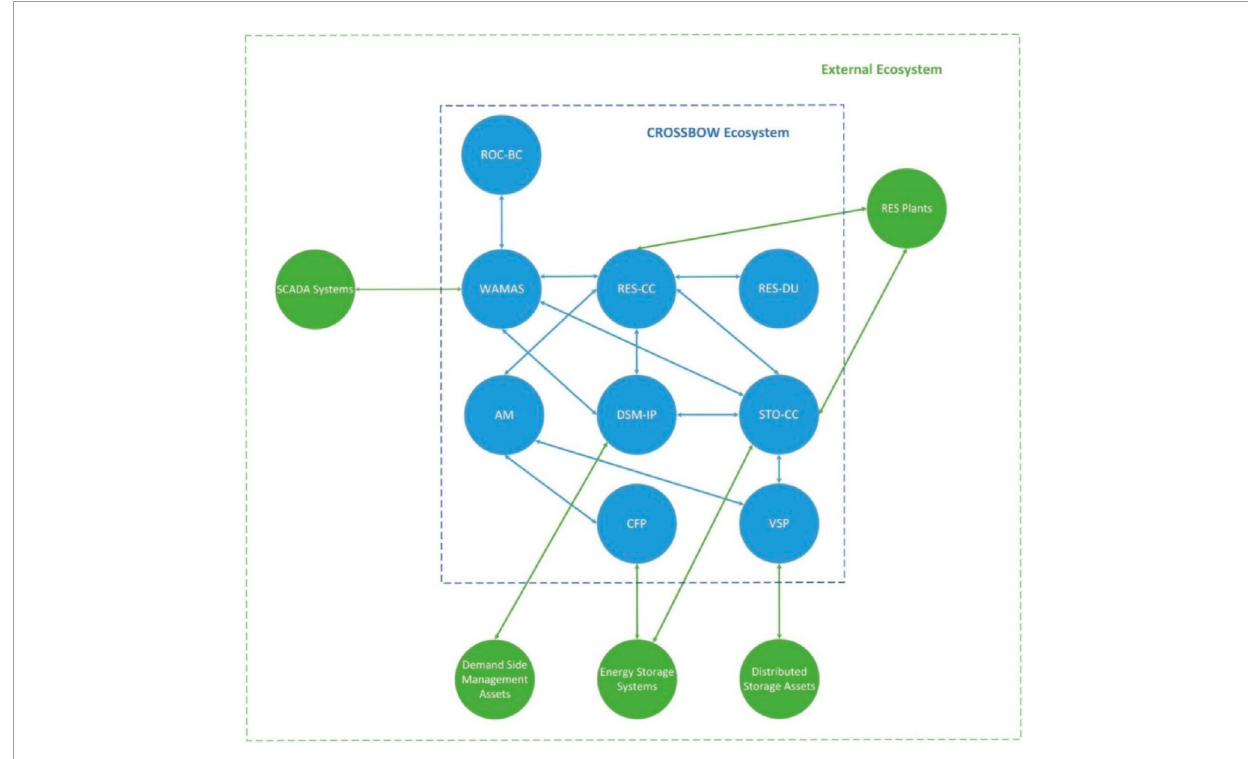
FIGURE 1 Diagram on internal CROSSBOW products integration and interoperability and external ones with other